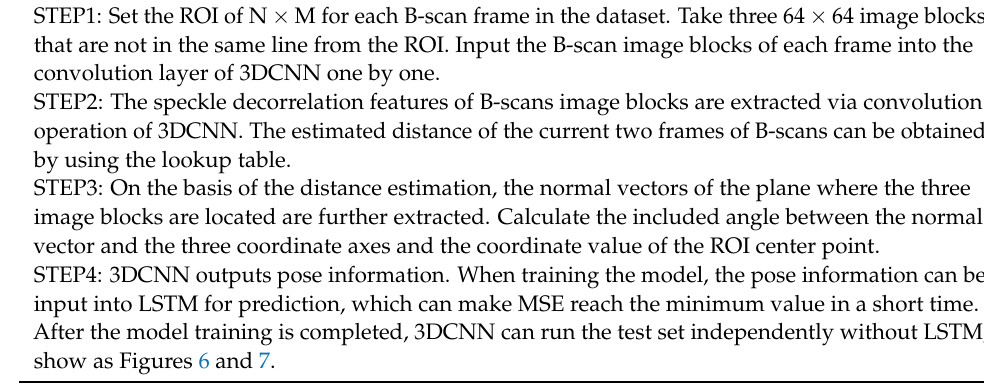
Algorithm 2: Speckle Decorrelation of